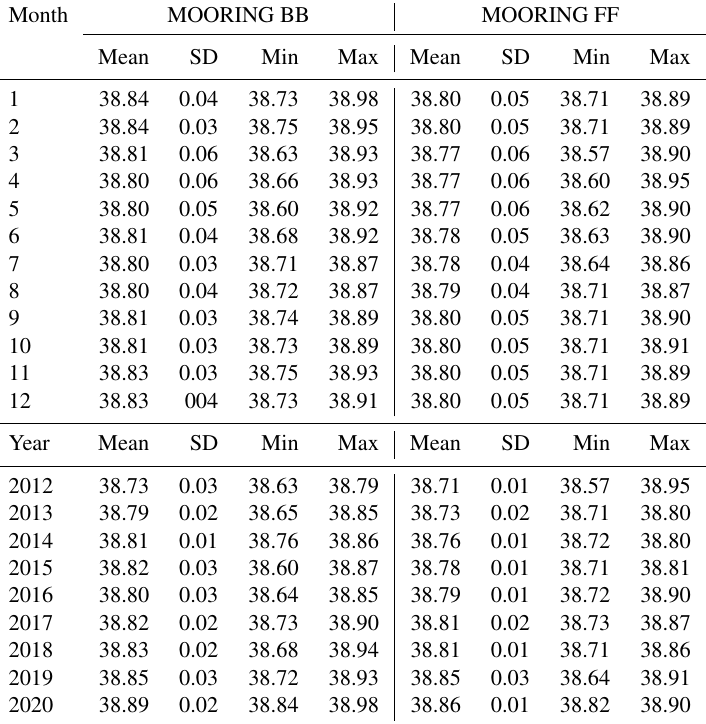
Table 6. Statistical parameters of salinity records of the two moorings grouped by months and years. SD indicates standard deviation and (cid:49) is the mean difference between temperature measured by ADCP and CTD and (cid:49) max is the maximum difference. The values reported in the table refer to original data (not